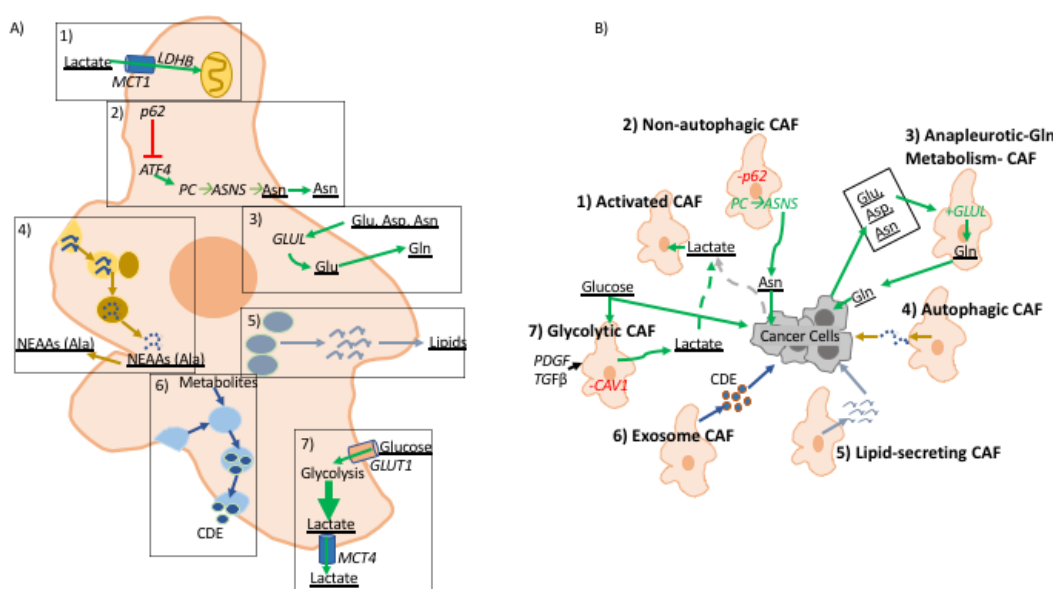
Figure 2. A role for fibroblast-derived metabolites in tumor-stroma interactions. ( A ) illustrates metabolic reprogramming in CAFs and ( B ) illustrates the effect of metabolites derived from CAFs to cancer cells in the TME. (1) Activated CAFs uptake excess TME lactate produced by glycolytic cells in the TME. (2) p62 deficient CAFs are autophagy defective and have upregulation of ATF4 which activates metabolic flux through pyruvate carboxylase (PC) → asparagine synthase (ASNS) pathway producing asparagine that is consumed by cancer cells. (3) CAFs characterized by upregulation of anapleurotic glutamine metabolism where cancer cell-derived aspartate, asparagine, and glutamate are used to generate glutamate that is fed to cancer cells; glutamine amino ligase (GLUL) is overexpressed in these CAFs. (4) Cancer cells induce autophagy in CAFs increasing turnover of non-essential amino acids, alanine has been shown to be up-taken by cancer cells to support growth. (5) Upon activation pancreatic and hepatic CAFs shift from lipid storing to lipid-secreting wherein CAF-derived lipids support proliferation and migratory potential of cancer cells. (6) Exosome releasing CAFs pack metabolic molecules used by cancer cells. (7) CAV1 deficient CAFs are known to upregulate glycolytic metabolism, as well as, fibroblast activation by PDGF and TGF β . ( A ) describes metabolic alterations in CAFs in dashed boxes. In both figures metabolic pathways are denoted with green arrows, cellular processes are assigned specific colors, and metabolic molecules are